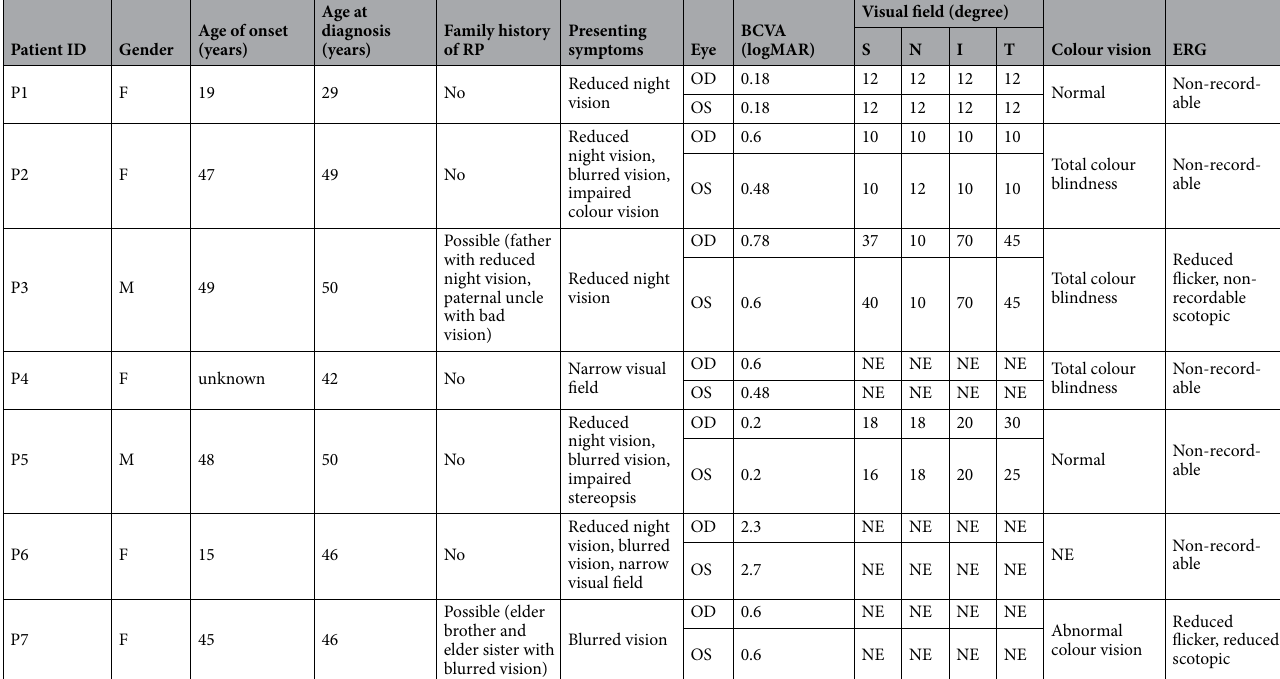
Table 2. Baseline demographic clinical presentation. BCVA, best corrected visual acuity; ERG, electroretinography; F, female; M, male; logMAR, logarithm of the minimum angle of resolution; OD, oculi